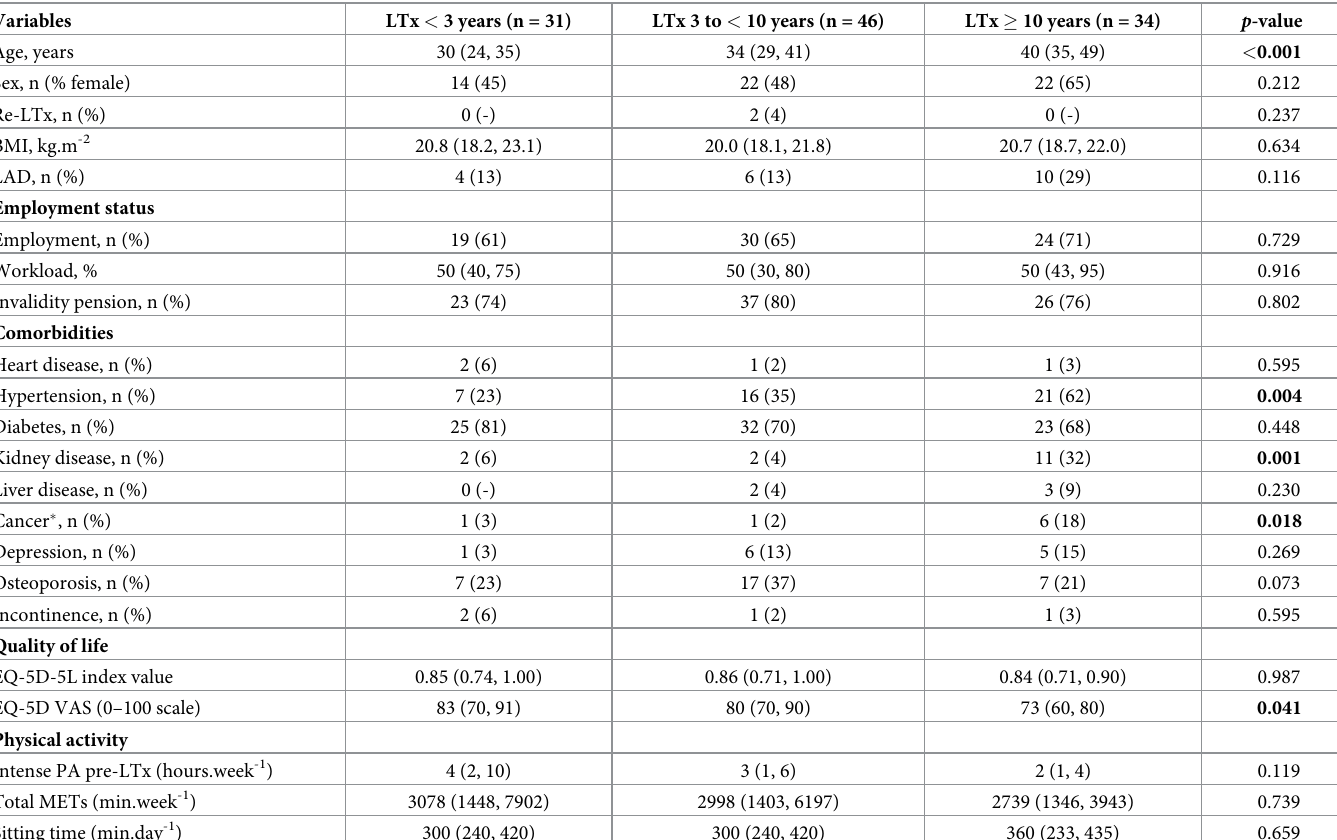
Table 2. Participants’ characteristics categorised according to time after lung transplantation (in years).